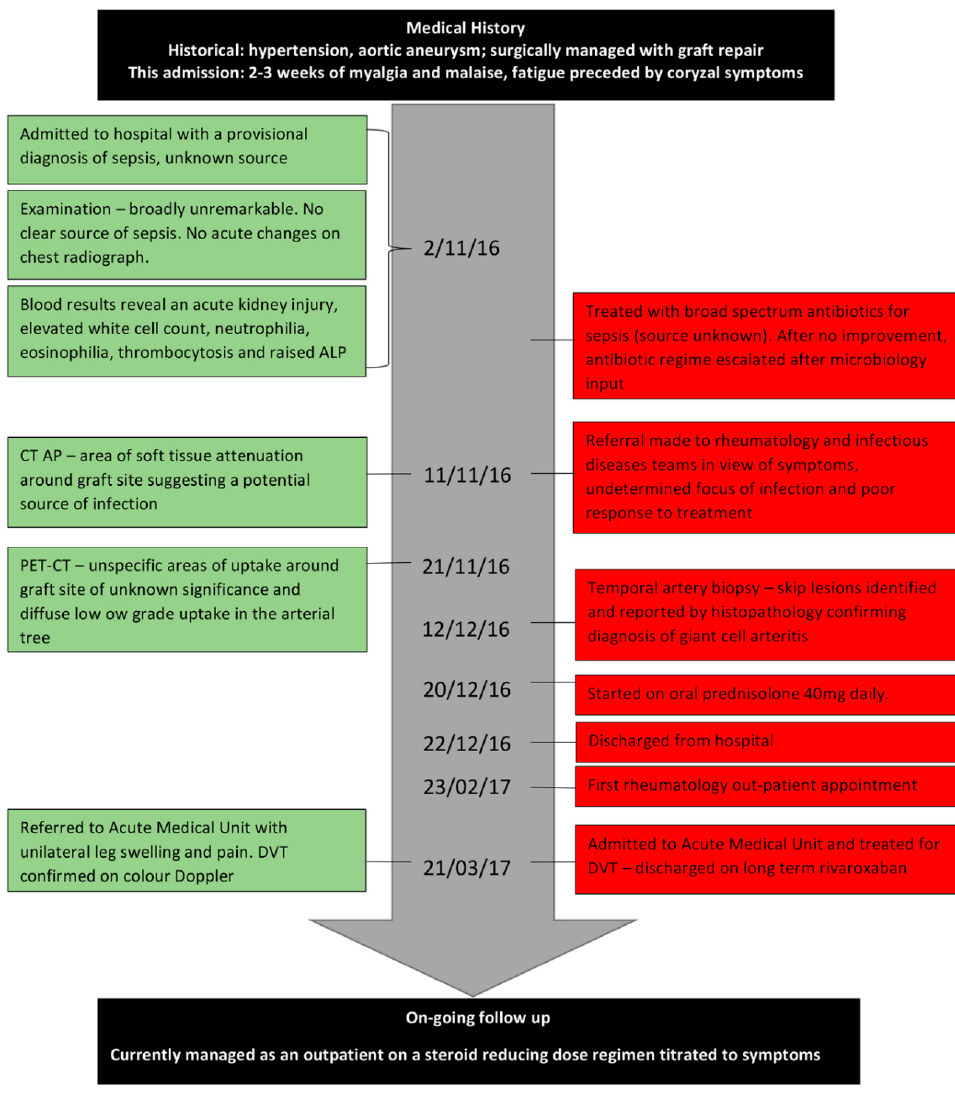
Figure 3. Time-line of patient JG’s journey from admission to follow up.